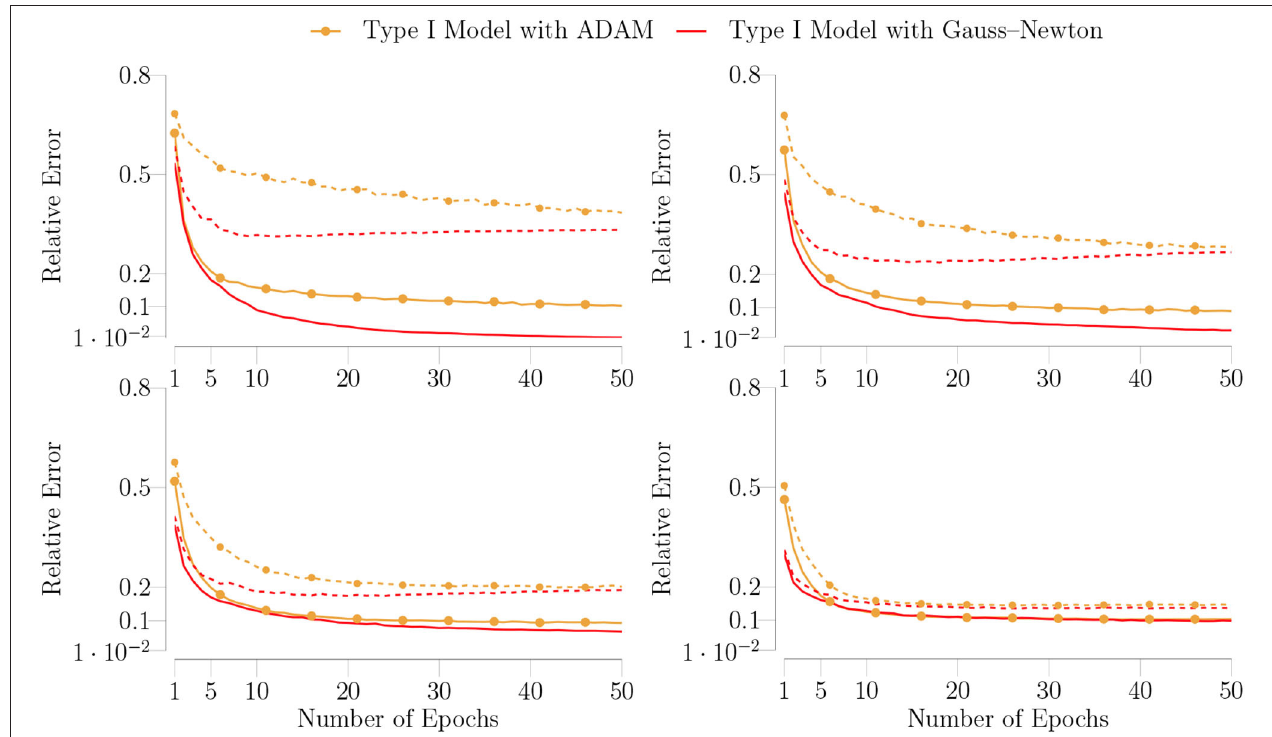
FIGURE 6 | Comparison of the median test (dashed lines) and training (solid lines) errors of the Gauss–Newton and the ADAM algorithms as a function of the number of epochs for 100 trials. The type I model for a rank-8 function given as in Equation (29) in the presence of SNR 20 dB Gaussian noise is used to generate the training and the test sets. The batch size is set to 10% of the training set size. For the Gauss–Newton algorithm, the maximum number of GN iterations and CG iterations is set to 1 and 5, respectively. For the ADAM algorithm, the step size, β 1 and β 2 are set to 0.01, 0.9, and 0.99, respectively. The number of training samples is set to 500 (top-left) , 1,000 (top-right) , 2,000 (bottom-left) , and 5,000 (bottom-right) . The presented Gauss–Newton algorithm produces more accurate results than the ADAM algorithm and also requires fewer number of epochs to converge in these experimental